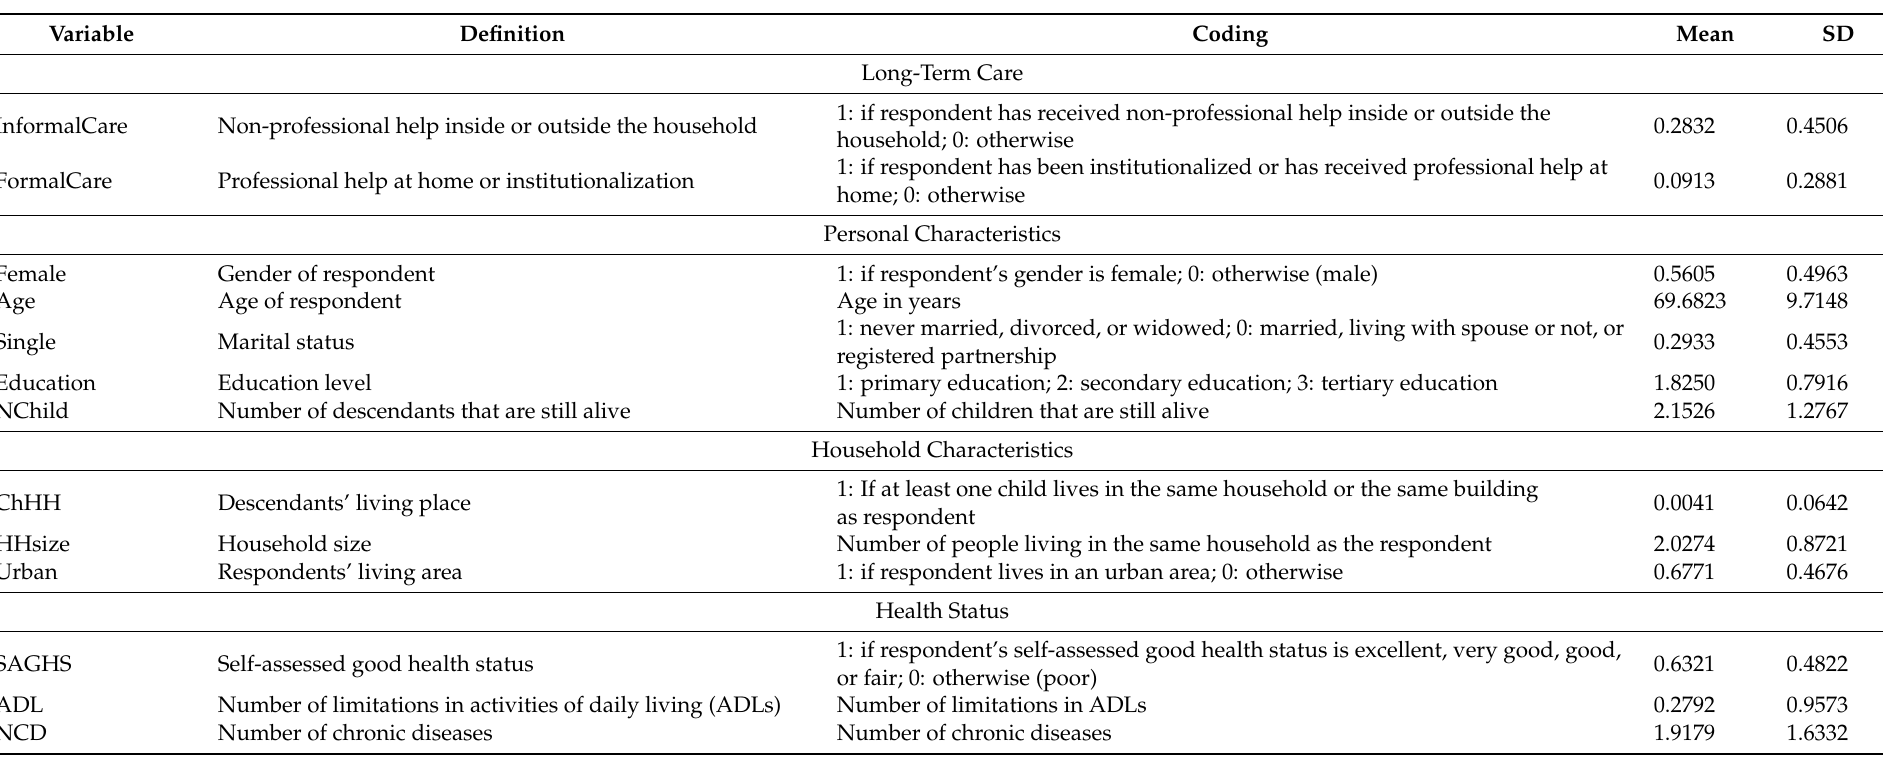
Table 1. Variable definitions and summary of statistics.